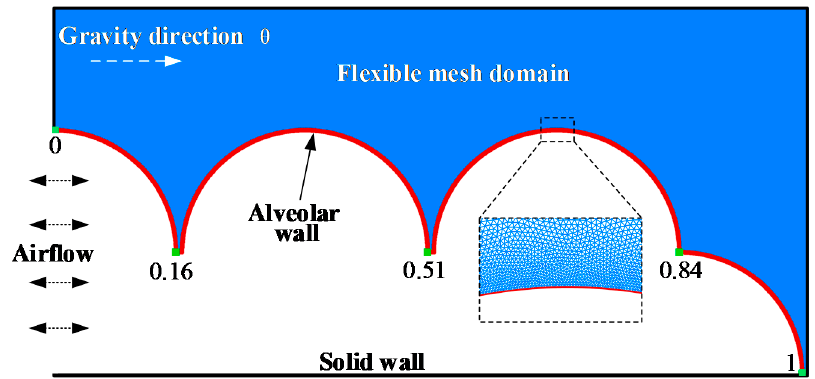
Figure 1. Terminal pulmonary acini.